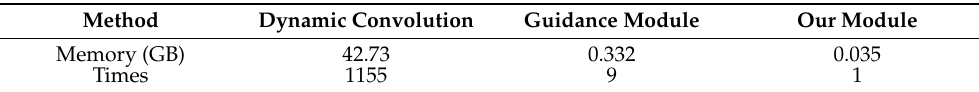
Table 2. GPU memory consumption for different methods, including dynamic convolution, guidance module, and our lightweight guidance